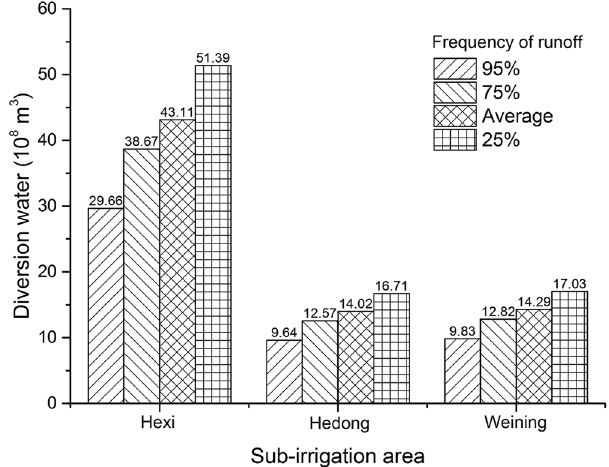
Figure 2. The amount of diverted water at different frequencies for three areas. Data are from Ningxia Water Conservancy 18